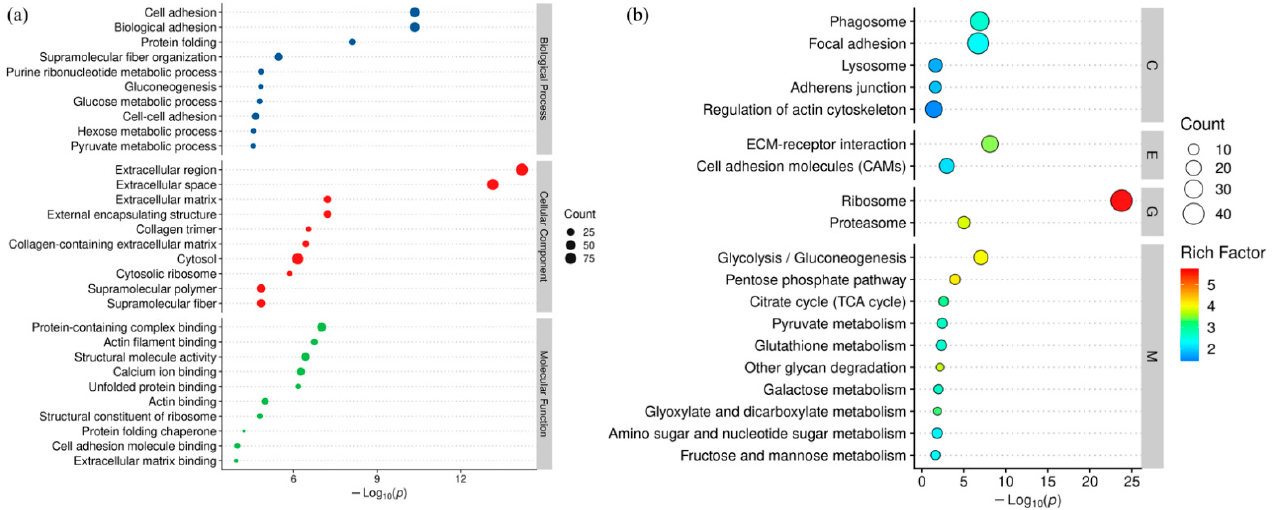
Figure 4. ( a ) GO function enrichment bubble chart. ( b ) KEGG pathway enrichment bubble map for DEPs.